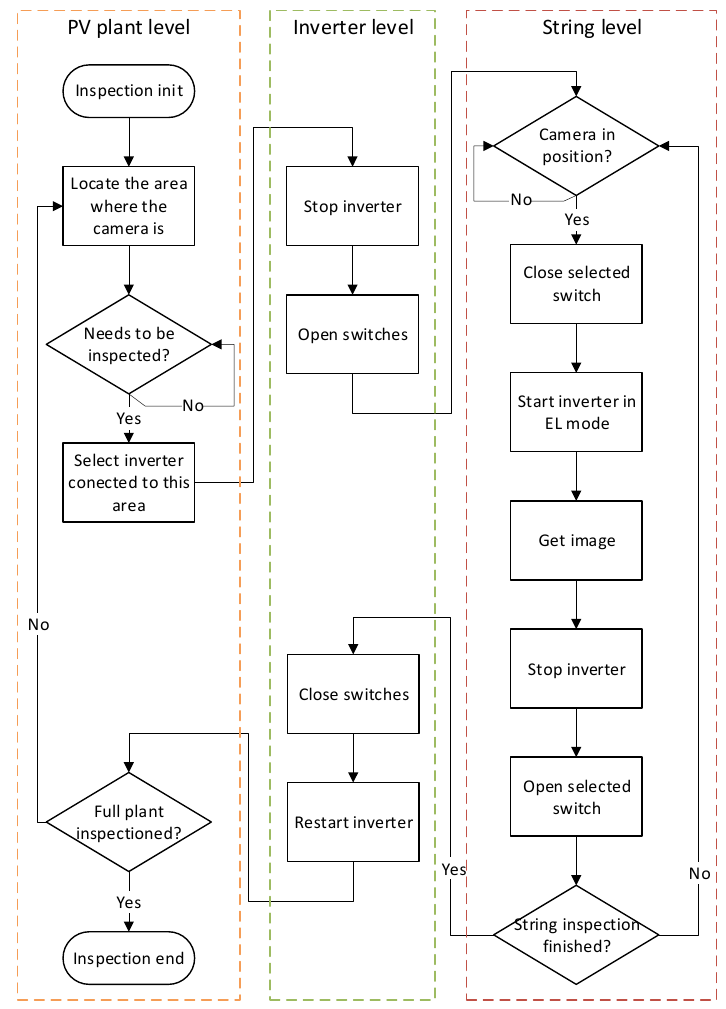
Figure 5. Complete system flow diagram for the maintenance of